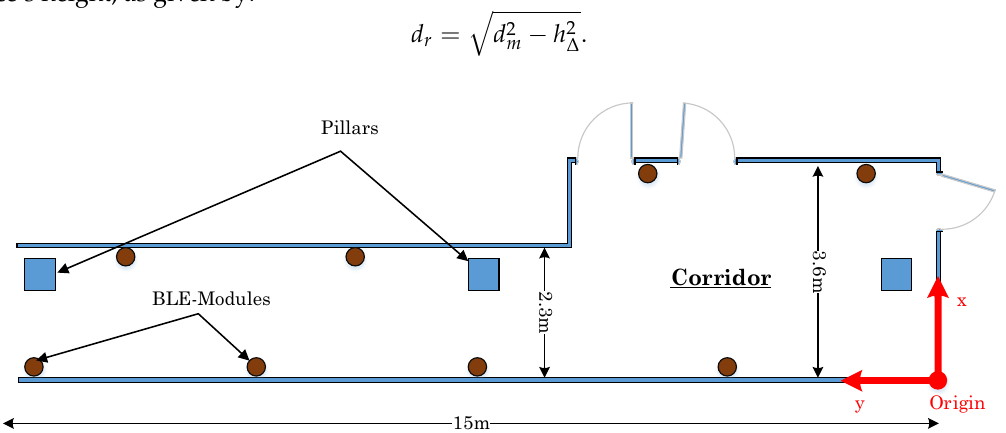
Figure 10. Layout of the implemented testbed.